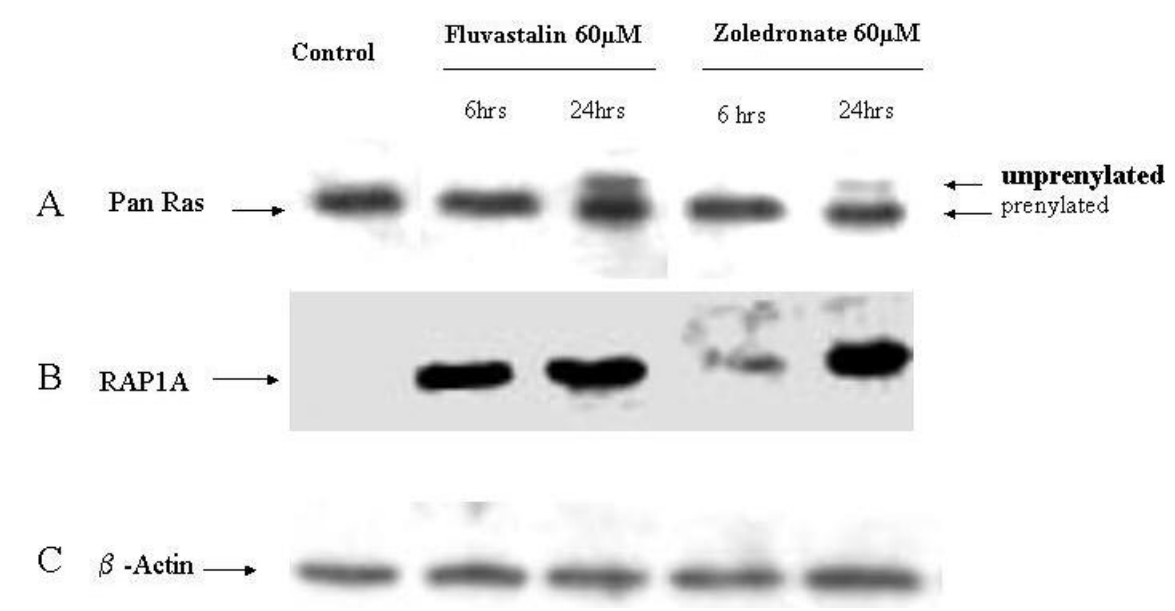
Figure 3. Inhibition of Ras and Rap prenylation by fluvastatin and zoledronic acid on T24 cells. T24 cells were grown in growth medium for 24 hours before harvest (control), or in growth medium containing the indicated drug for 6 to 24 hours. ( A) anti-Ras antibody (farnesylation marker) can bind to both unprenylated and the prenylated ras. The unfarnesylated form migrates more slowly than the farnesylated form as indicated on the right side of the panel. Both drugs inhibit Ras farnesylation at 24h treatment but not 6h. (B) anti-Rap1A (geranylgeranylation marker) can only bind to the unprenylated Rap, and results show that fluvastatin inhibits Rap geranygeranylation at both 6 and 24 hours treatment, while zoledronic acid shows greater inhibition at 24h treatment and less inhibition at 6h. ( C) β-actin as loading